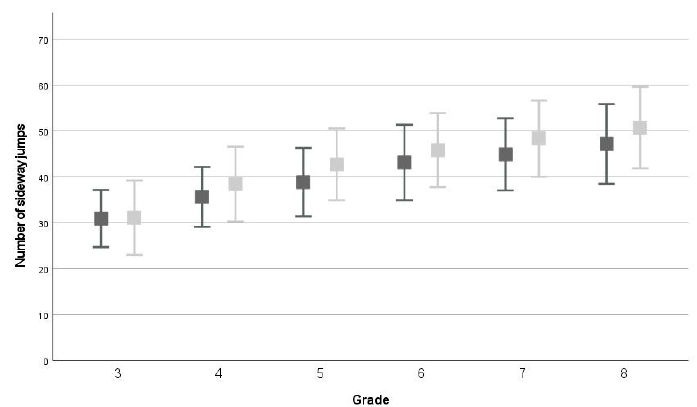
Figure 2. Average and standard deviation on jumping sideways test at T0 (dark grey) and T1 (light grey).